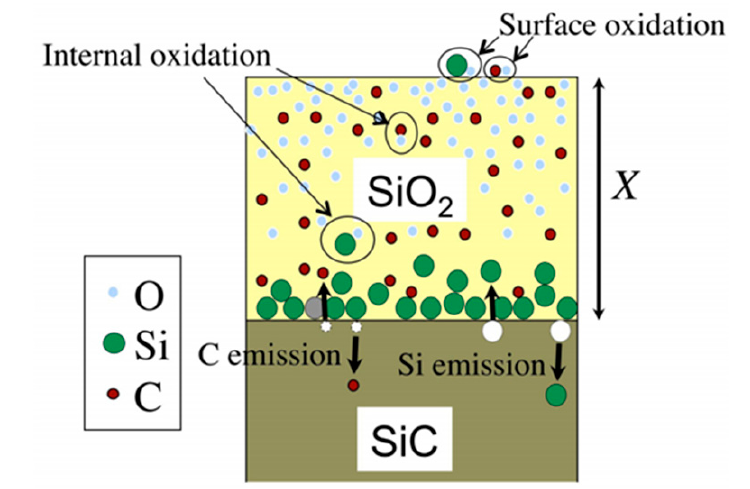
Figure 6. Schematic view of the Si and C emission model. Reprinted with permission from [17]. Using the work of Kageshima et al. the interfacial reaction rate is defined by the following: where C I and C 0 are the concentration of the species at the interface and the solubility limit x x of the species,